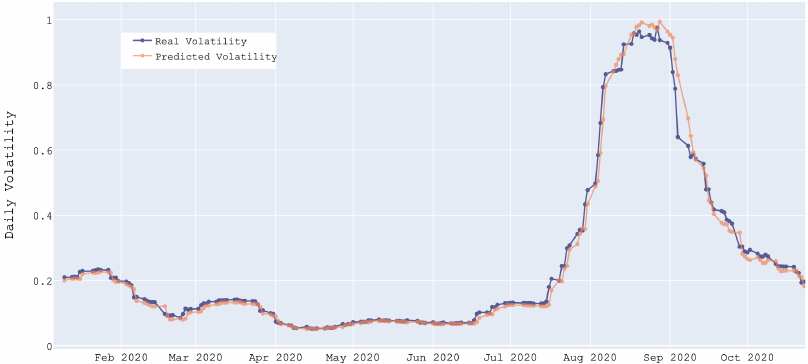
Figure 7. Predicted volatility and historical volatility for the period January 2020–October